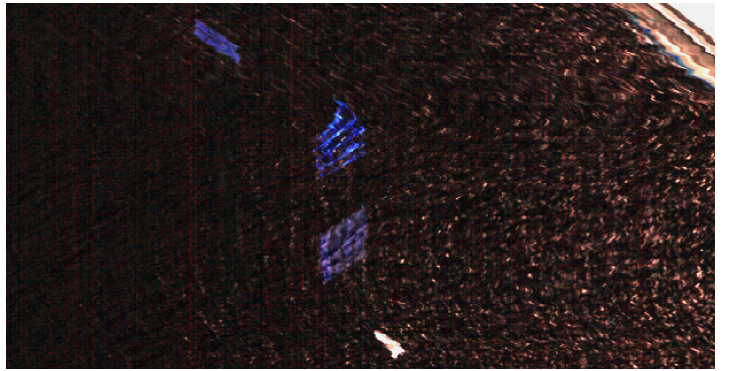
Figure A1. Waterfall image of the flyby analyzed from the 18/9 afternoon F-BUMA flight. In Figure A2 is possible to see the spectral response (in normalized radiance) for all the three targets, compared with laboratory results for the wet samples.